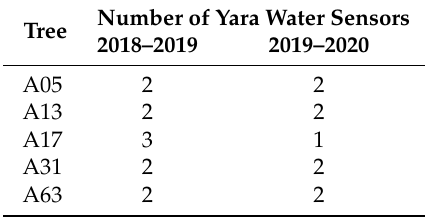
Table 3. Yara Water Sensors installed in each monitored tree.